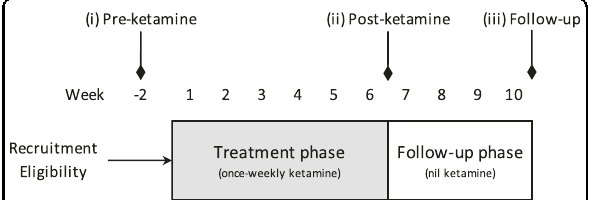
Fig. 1 Oral Ketamine Trial on Suicidality (OKTOS) design. Following recruitment and determination of eligibility, OKTOS participants underwent (i) baseline ( ‘ Pre-ketamine ’ ) assessments within 14 days prior to commencing treatment. Treatment phase involved once-weekly doses of oral ketamine; this was followed by 4 weeks of nil ketamine. Two major endpoints: (ii) ‘ Post-ketamine ’ (week 6); and (iii) ‘ Follow-up ’ (week